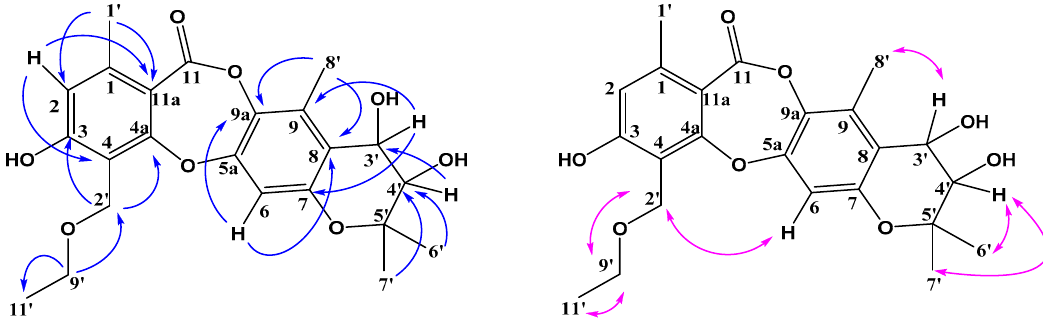
Figure 3. Key HMBC (H-C) correlations and NOESY (H-H) correlations of mollicellin P ( 2 ).